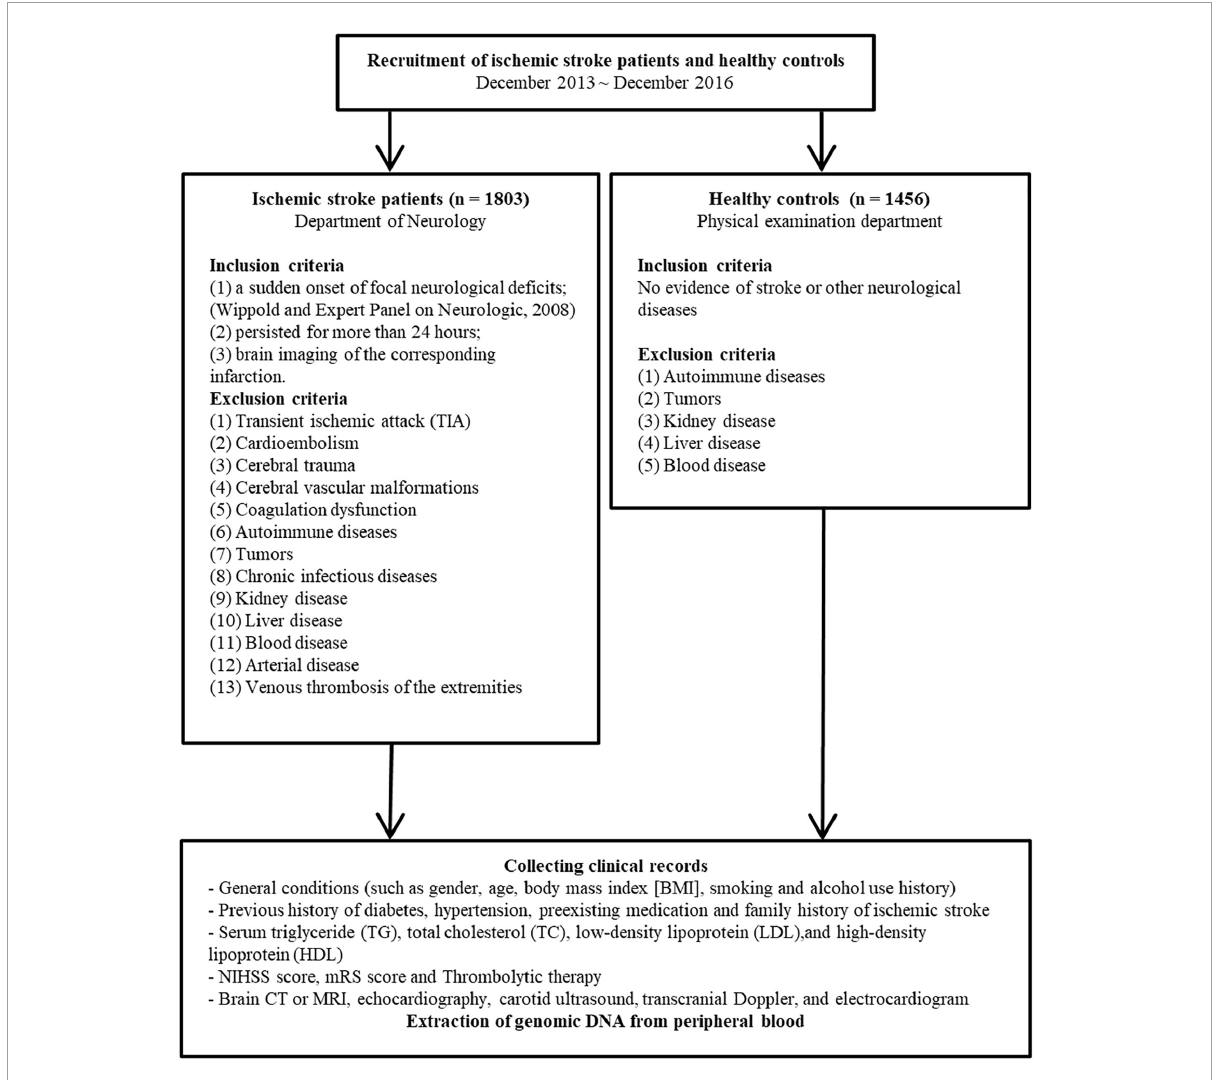
FIGURE1 Patient and controls enrollment flowchart. (NIHSS, National Institutes of Health Stroke Scale; mRS, modified Rankin